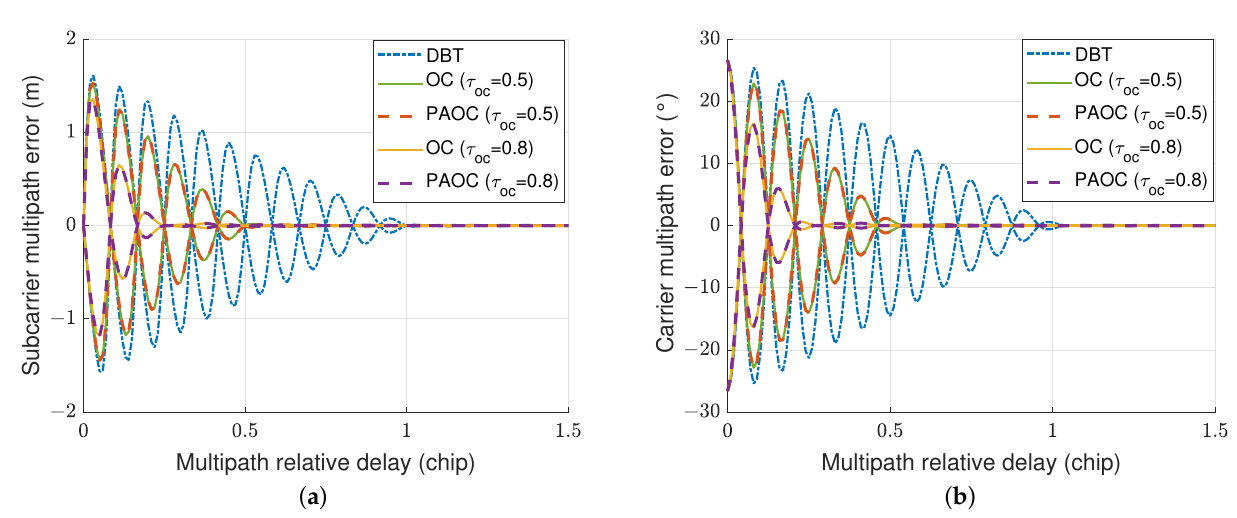
Figure 7. MEEs of the DBT, OC, and PAOC techniques for the BOC(15, 2.5) signal with a bandwidth of 40.96 MHz: ( a ) subcarrier MEE; ( b ) carrier